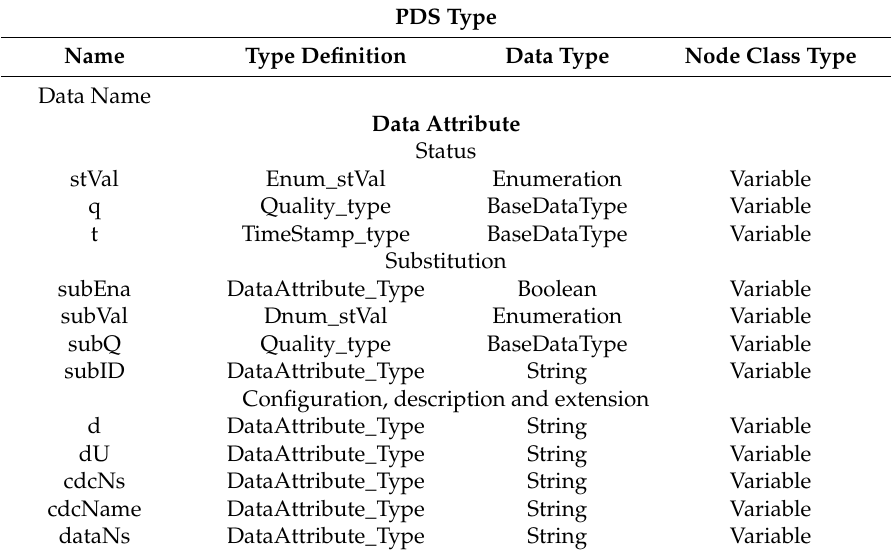
Table 3. Example of common data class: DPS (double point status)